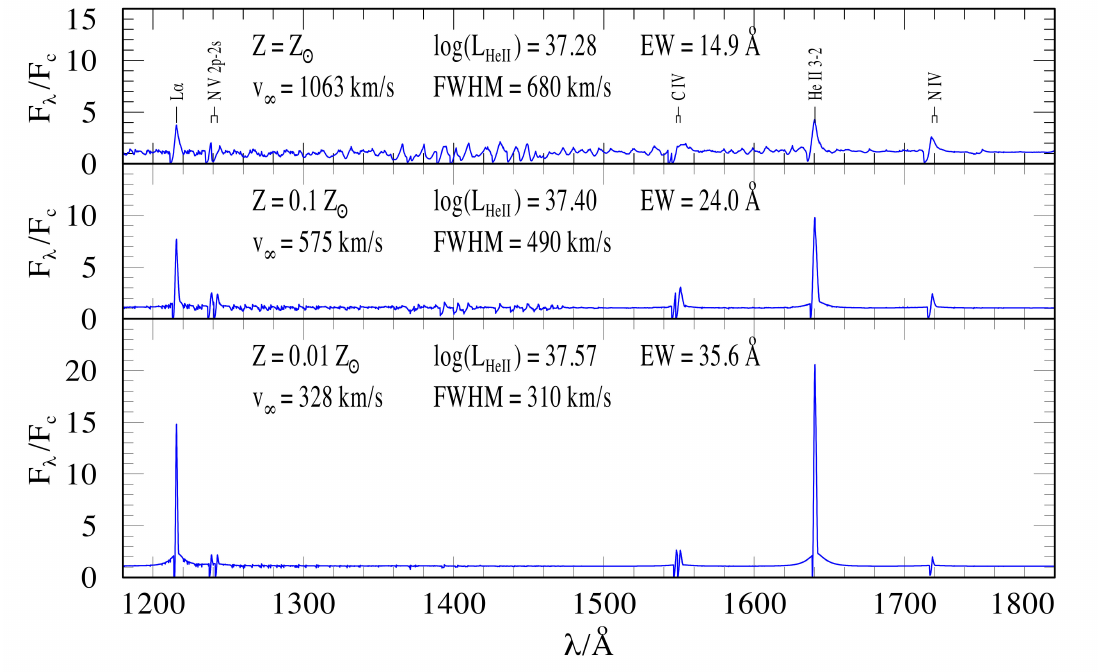
Figure 4. Synthetic UV spectra for different metallicities Z from wind models for VMS from Gräfener& Vink (2015). The presented models are computed for luminosities of log ( L / L (cid:12) ) = 6.3, a stellar temperature T (cid:63) = 45kK, and have very similar mass-loss rates ( ∼ 1.8 × 10 − 5 M (cid:12)